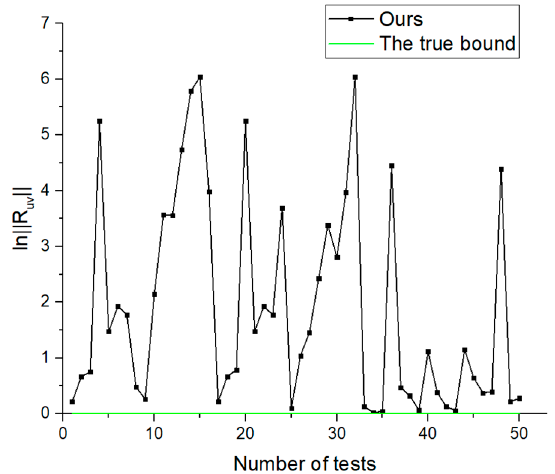
( ) R u of NURBS surfaces ( ) uv R u of NURBS surfaces uv